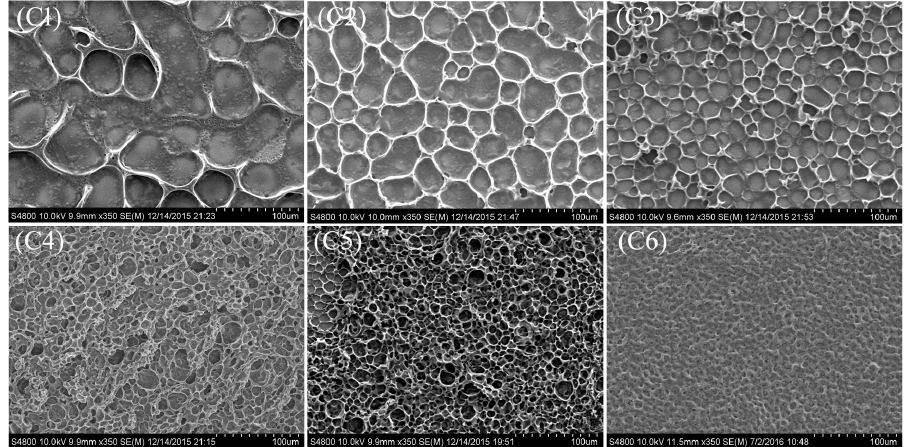
Figure 4. SEM micrographs of the polymer networks of the samples C1 – C6 .